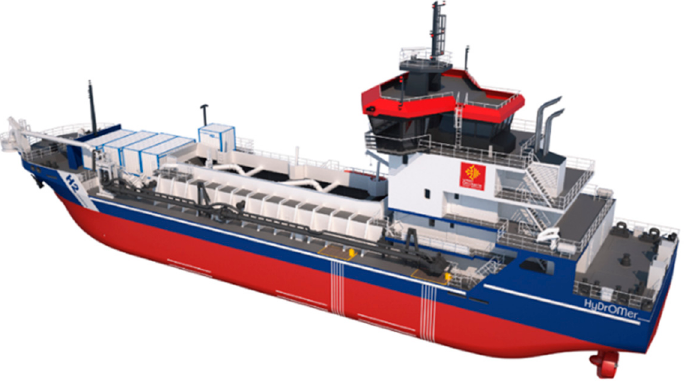
Figure 17. The dredger “HyDrOMer” [92,93].